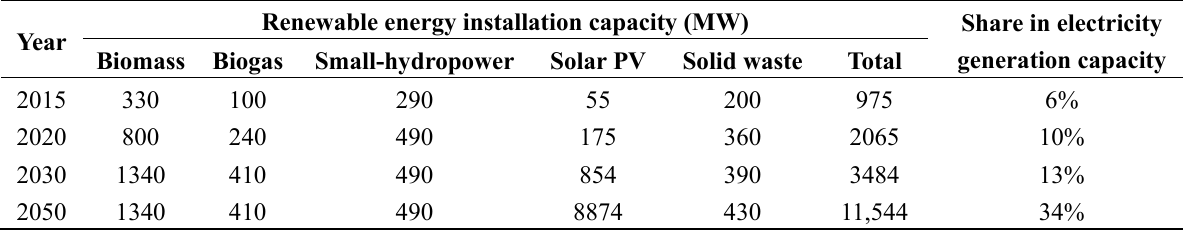
Table 11. Policy target of installed capacity of renewable power in